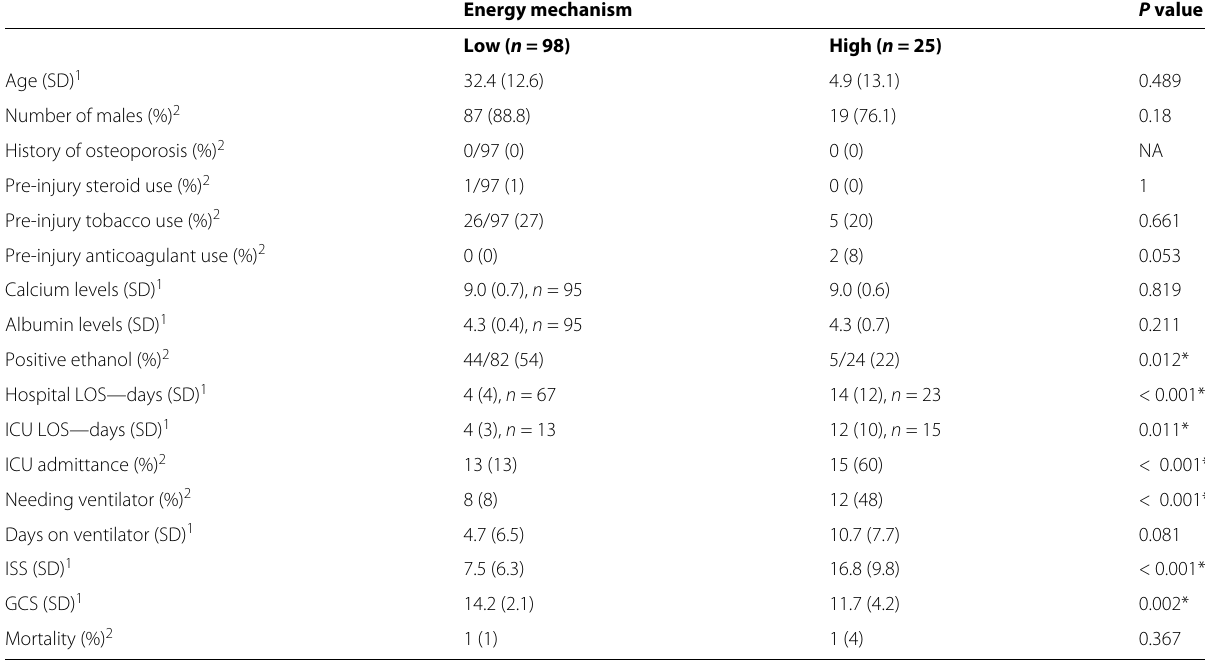
Table 2 Patient demographics, comorbidities, and outcomes